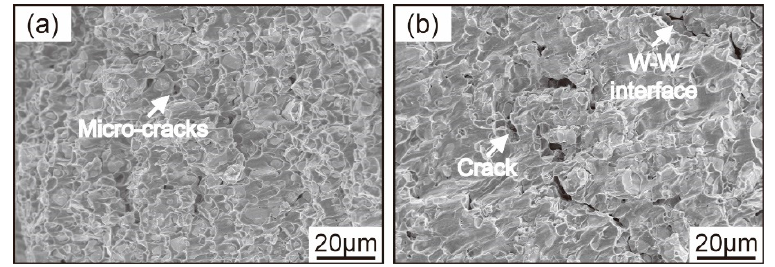
Figure 7. SEM micrographs of the fracture surfaces of W-30Cu composites under dynamic compression conditions: ( a ) the SCI composite; ( b ) the BCI composite.